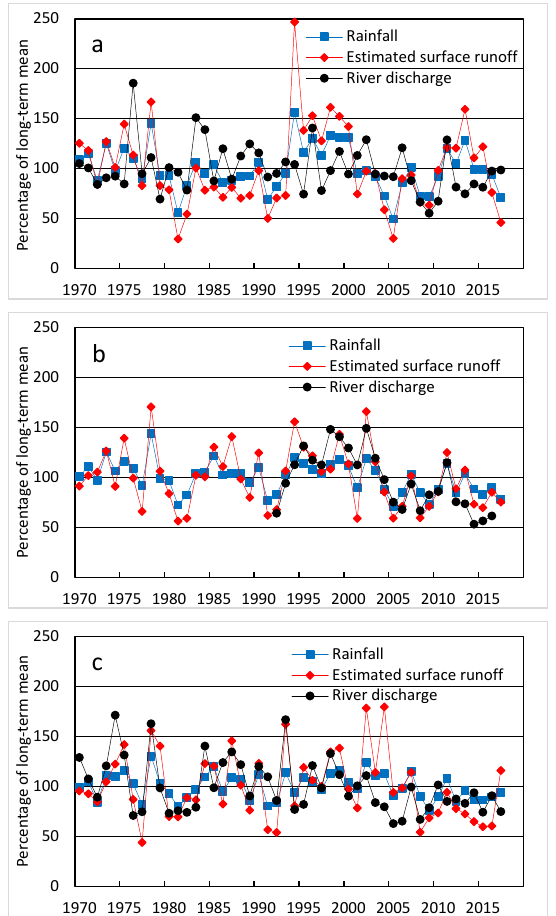
Figure 7. Relationships of annual river discharge with rainfall and estimated surface runoff (derived based on rainfall and LULC) for ( a ) headwater, ( b ) upper and ( c ) entire catchments. Note: values on y-axis represent percentages in relation to corresponding long-term means.